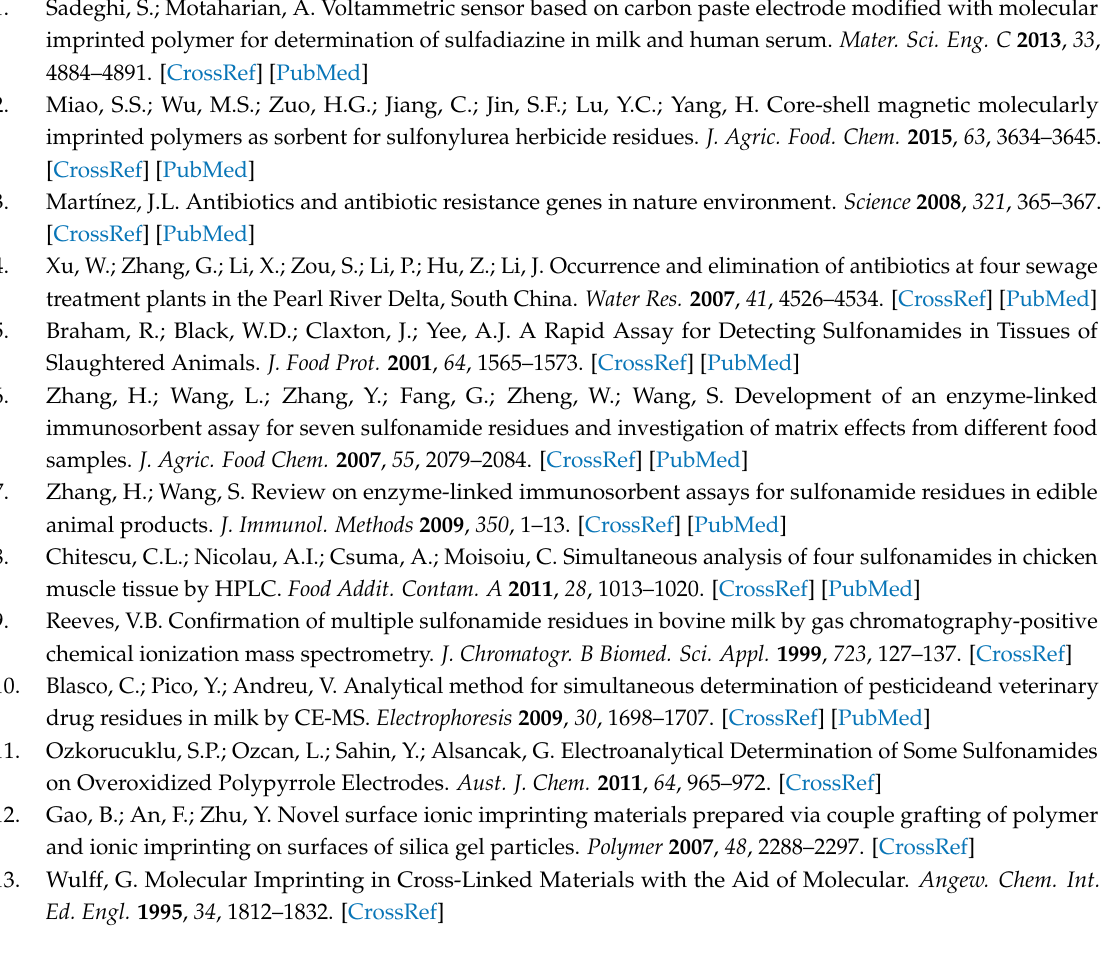
Table S1: the standard deviation of the parameters in each fitting